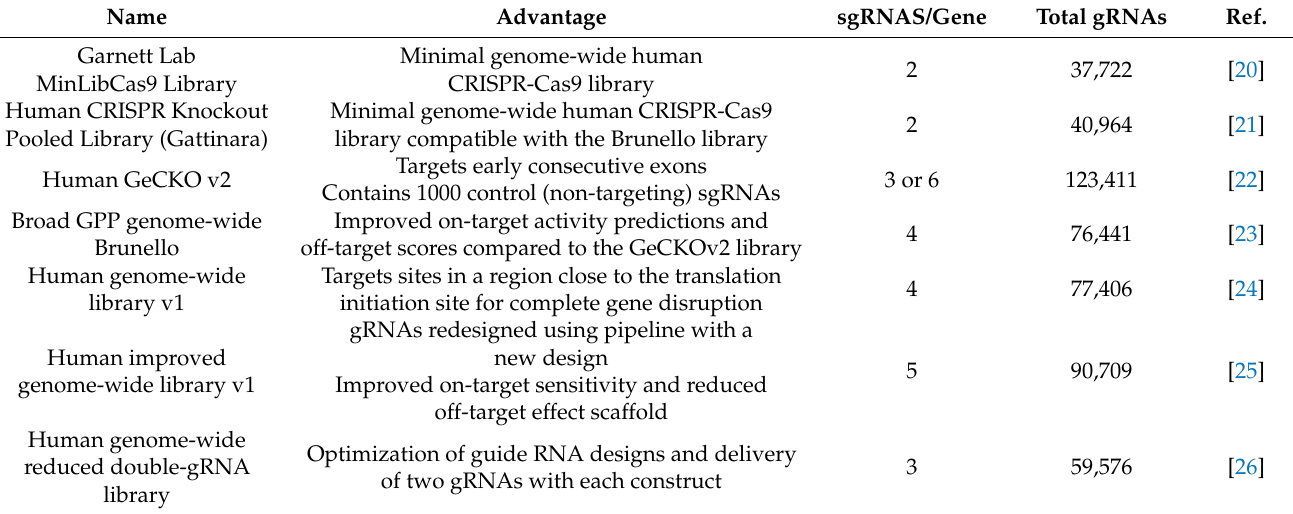
Table 1. CRISPR knockout